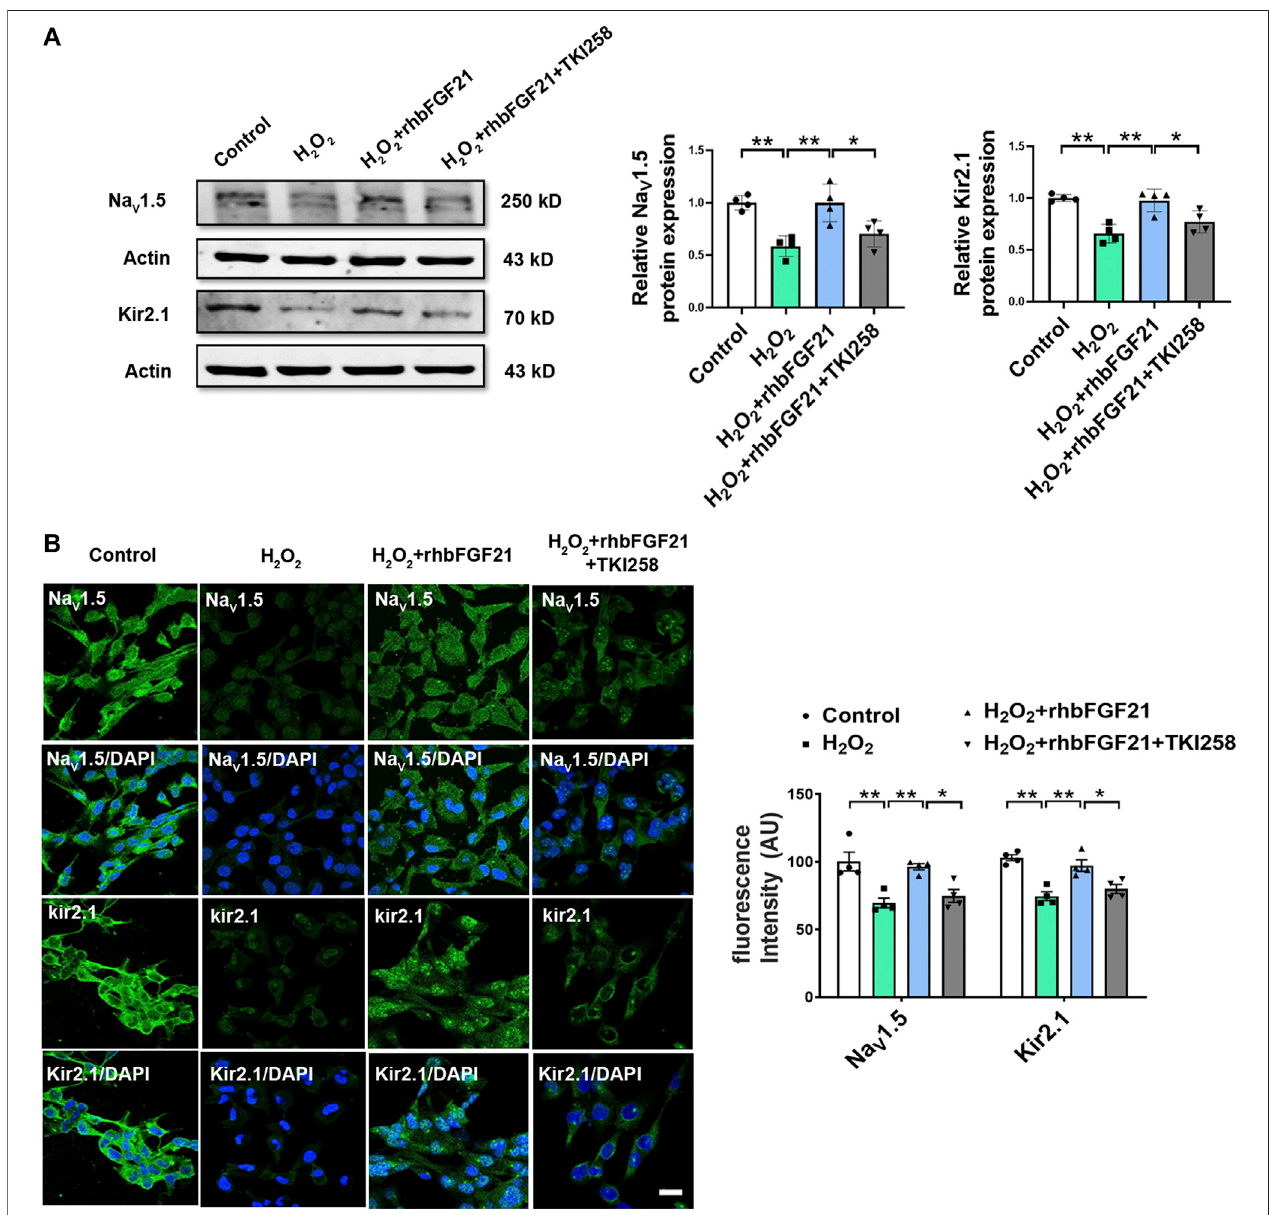
FIGURE 4 | Effect of FGFR on Na V 1.5 and Kir2.1 expression. (A) Protein level of Na V 1.5 and Kir2.1 in AC16 human cardiomyocytes in Control, H 2 O 2 , H 2 O 2 +rhbFGF21, and H 2 O 2 +rhbFGF21 + TKI258 group, n (cid:1) 4 batches of cells, * p < 0.05; ** p < 0.01. Analysis by one-way ANOVA, mean ± SEM. (B) Immuno fl uorescence staining of Na V 1.5 and Kir2.1 expression in AC16 human cardiomyocytes in each group. * p < 0.05; ** p < 0.01. Analysis by one-way ANOVA, mean ± SEM. Scale bar indicates 100 μ